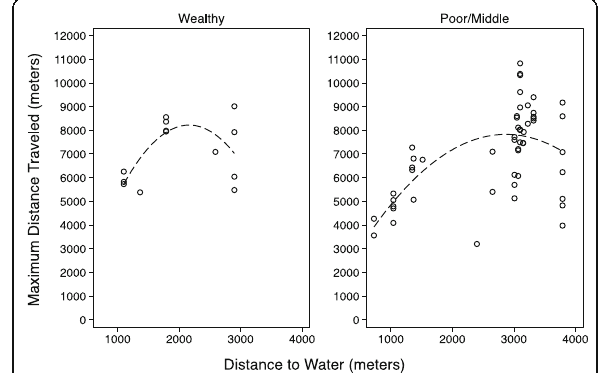
Figure 16 Quadratic fit of herding radius as a function of maximal distance to water by wealth rank. Wealthy families travel shorter distances to complete their grazing circuit before returning home. They can do this since they spend less time trekking their herds to